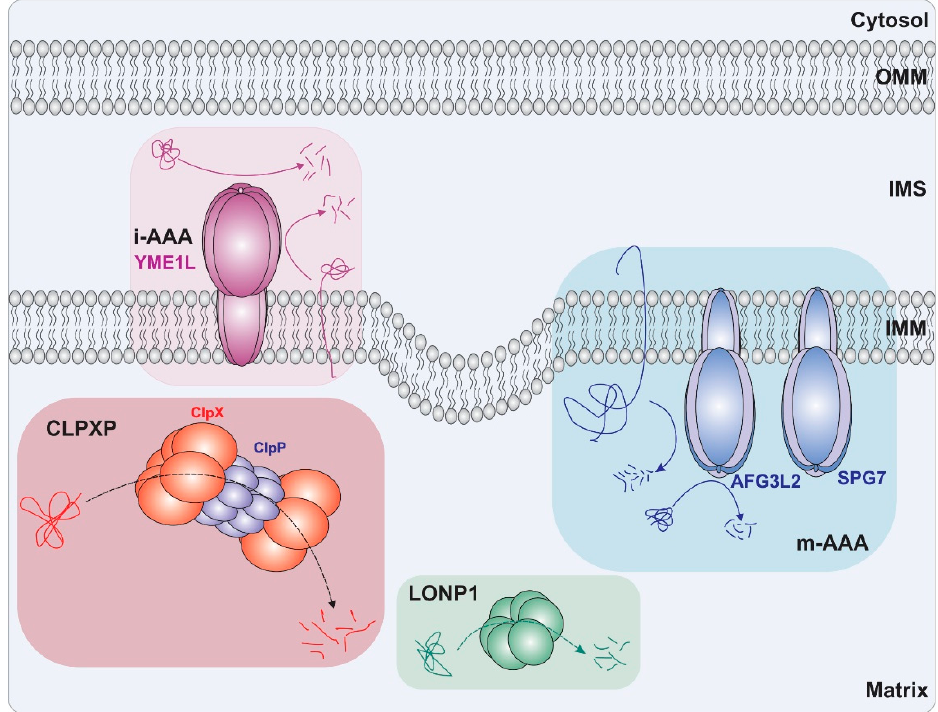
Figure 1. Schematic representation of mitochondrial ATP-dependent proteases. Mammalian mito- chondria comprise four different proteases of the AAA+ superfamily for regulating protein quality control: The ClpXP complex and Lon protease 1 in the matrix and the i-AAA and m-AAA proteases in IM. Abbreviations: IMM, inner mitochondrial membrane, OMM, outer mitochondrial membrane; IMS: intermembrane space.